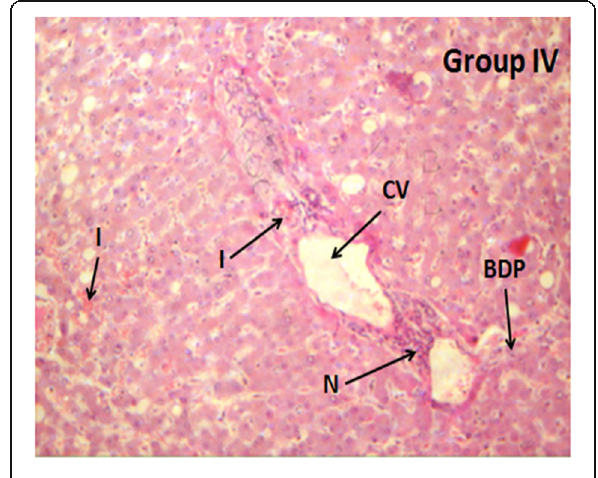
Fig. 2 Photomicrograph of the liver from a bird in group IV at the end of 12 weeks of direct exposure to 3 mg CN kg − 1 body weight. CV, central vein; N, necrosis; I, inflamation; BDP, bile duct